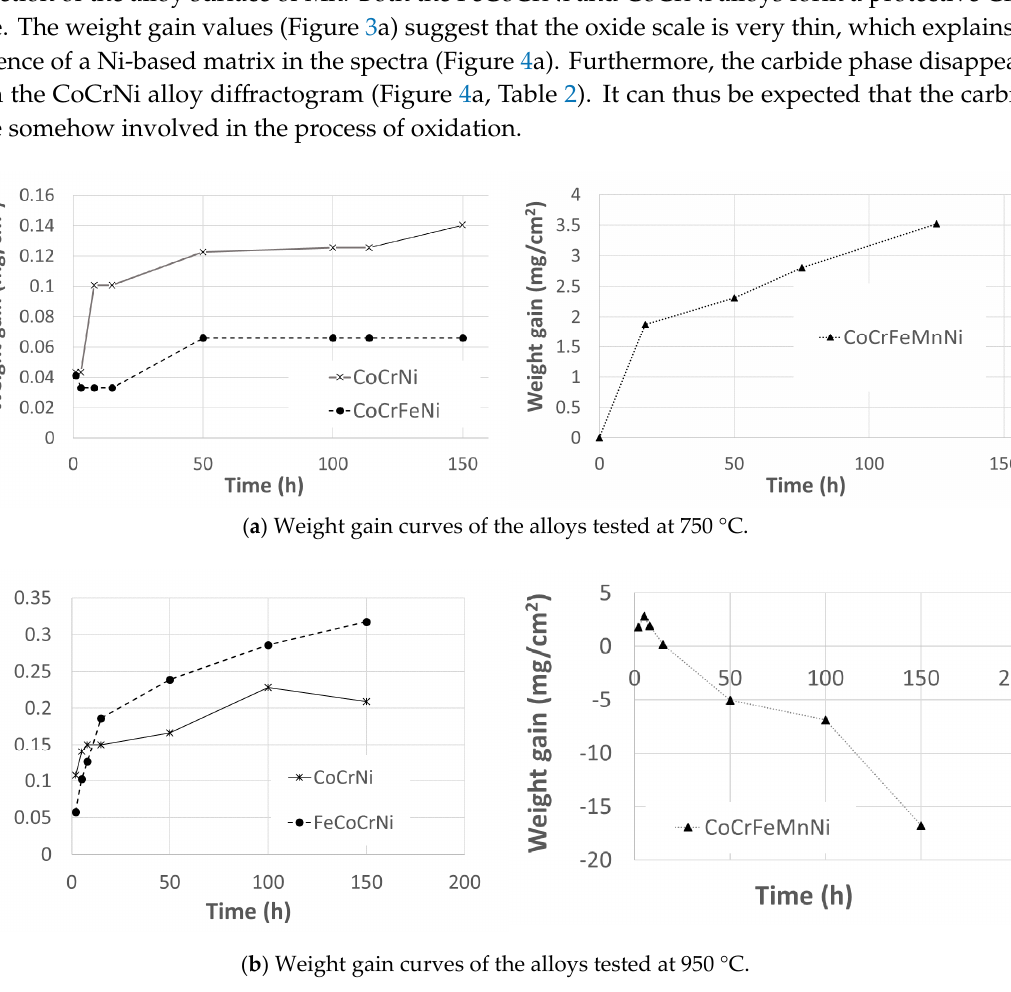
Figure 3 . Oxidation kinetics represented by cumulative weight gain within 150 h of air exposure at high temperatures. Major spallation was observed only for CoCrFeMnNi at 950 °C, and the debris were not included in the measured weight.